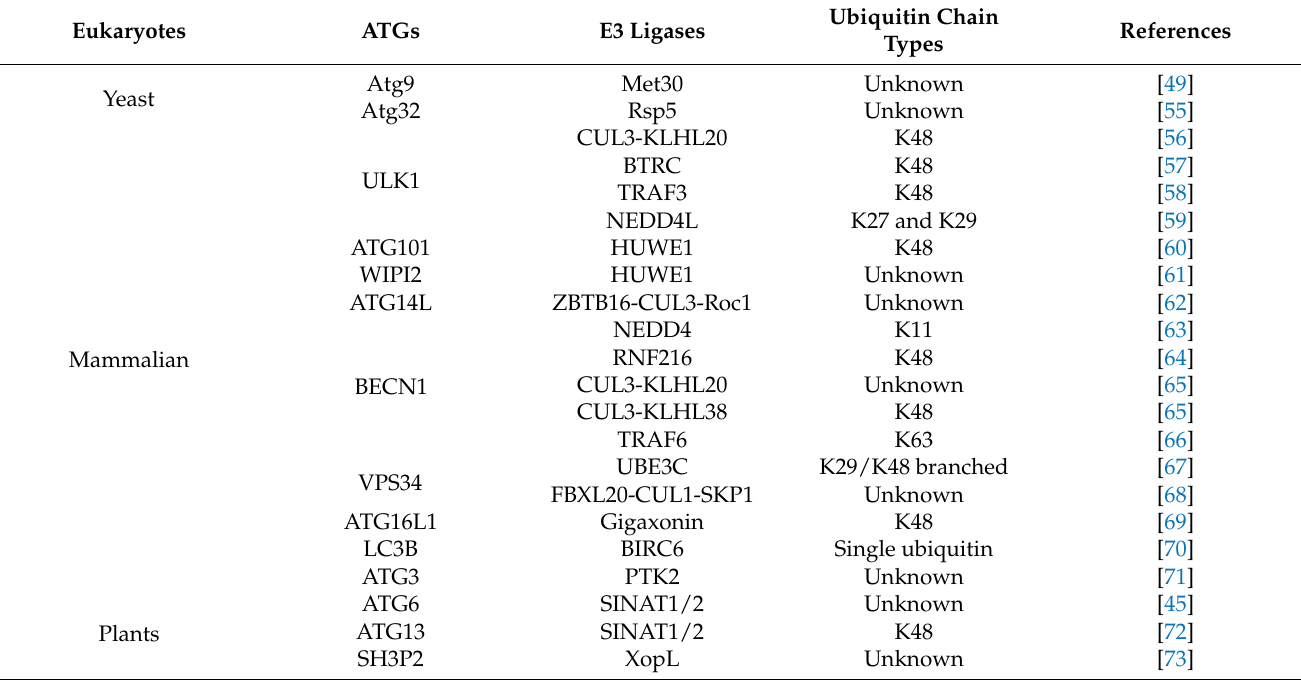
Table 1. E3 ligases and ubiquitin chain types involved in ATGs degradation in yeast, mammalian, and